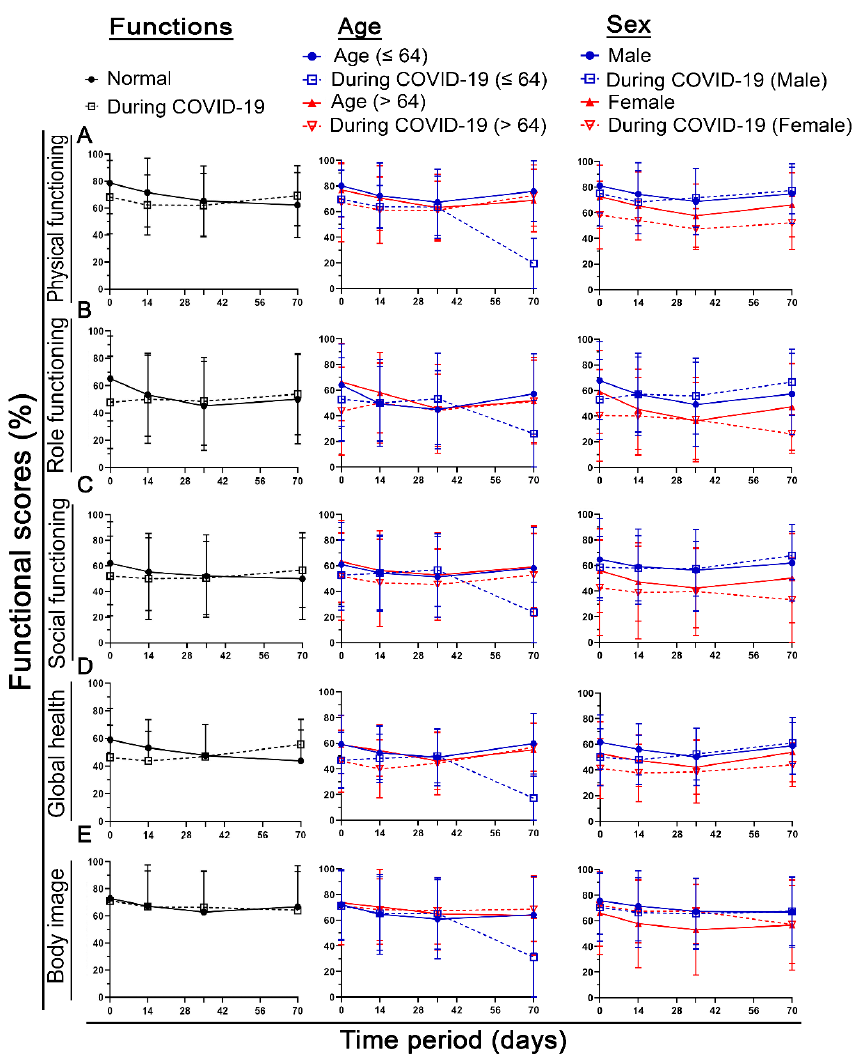
Figure 6 . Time course of different functional scores at day 1, day 14, day 35, and day 70. In the first column, the entire cohort is separated into normal (before COVID-19) and during COVID-19. In the second column, the cohort was divided into patients younger or 64 to older than 64. In the third column, females and males of the cohort were compared for ( A ) physical function, ( B ) role function, ( C ) social function, ( D ) global health status, and ( E ) body image. Error bars indicate the standard deviation.